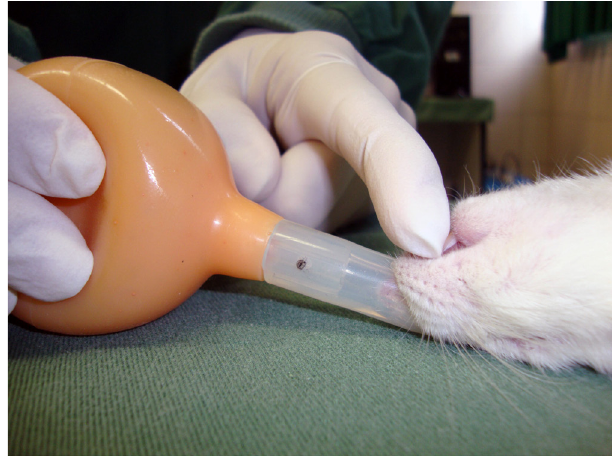
Fig. 1 - Nasal respirator for manual ventilation of the G2 rats during the thoracotomy and occlusion of the left anterior descending branch of the left coronary artery .